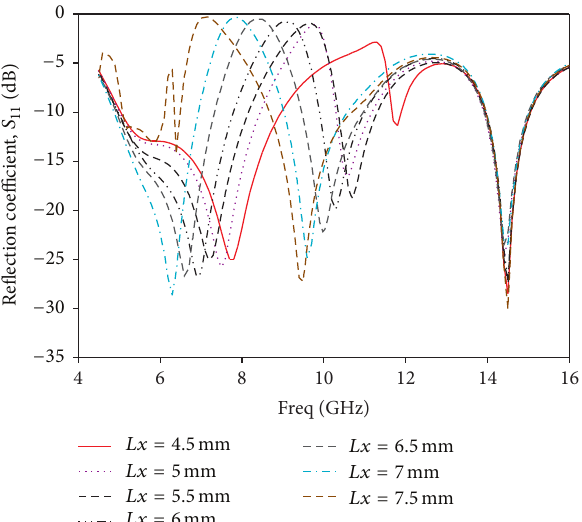
Figure 4: Magnitude of the simulated reflection coefficient of the PIFA versus frequency for different values of the geometrical parameter 𝐿𝑥 .